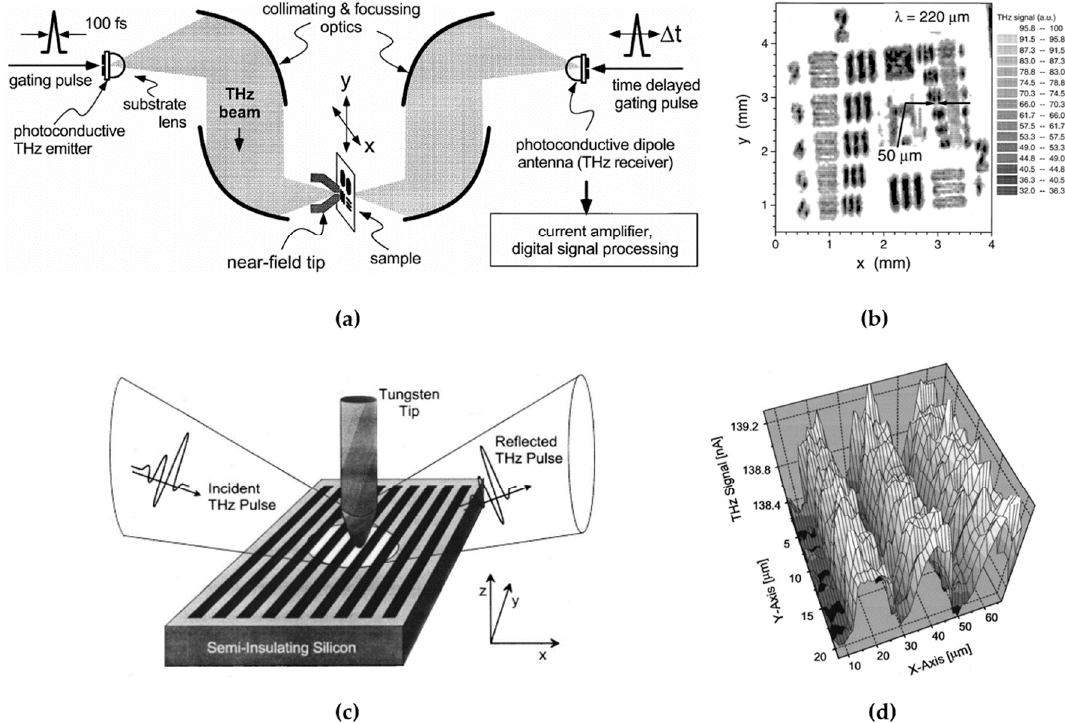
Figure 7. Early work of sub-wavelength THz imaging: ( a ) Imaging setup using a tapered metal tip and ( b ) the measured test sample showing 50 µm resolution at 220 µm. Reprinted with permission from [101]. ( c ) THz SNOM setup for imaging of a silicon-gold grating and ( d ) the resulting image with a spatial resolution of 150 nm. Reprinted with permission from